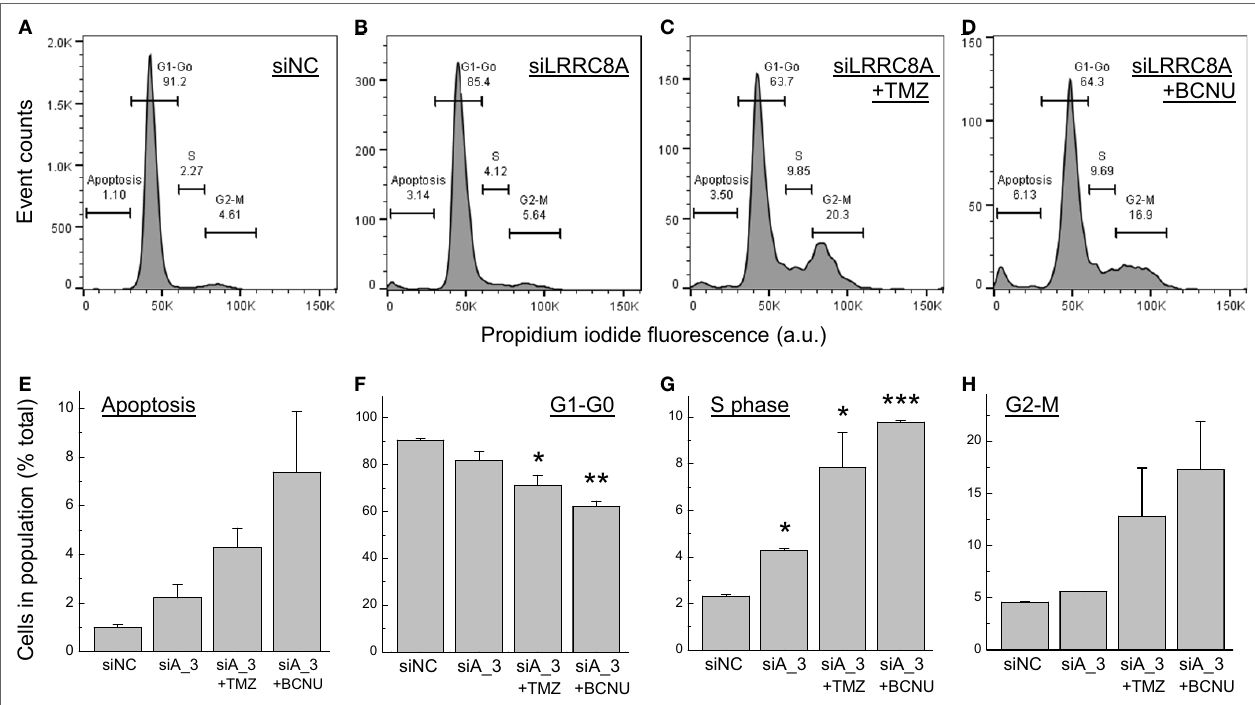
FigUre 6 | Fluorescence-assisted cell sorting (FACS) analysis of cell proliferation in glioblastoma (GBM) cells treated with leucine-rich repeat-containing 8A (LRRC8A) siRNA and chemotherapeutics agents. DNA content in fixed and permeabilized GBM cells was determined after staining with propidium iodide using FACS analysis, as described in Section “Materials and Methods.” (a–D) Representative FACS data in cells treated with negative control siRNA (siNC), LRRC8A siRNA (siA_3), or their combination, as specified. (e–h) Quantitation of FACS data for cells segregated in apoptotic (e) , G 1 –G 0 (F) , S phase (g) , and G 2 /M (h) populations. The data are the mean values ± SE of three independently transfected cell populations. * p < 0.05, ** p < 0.01, *** p < 0.001, vs. cells transfected with